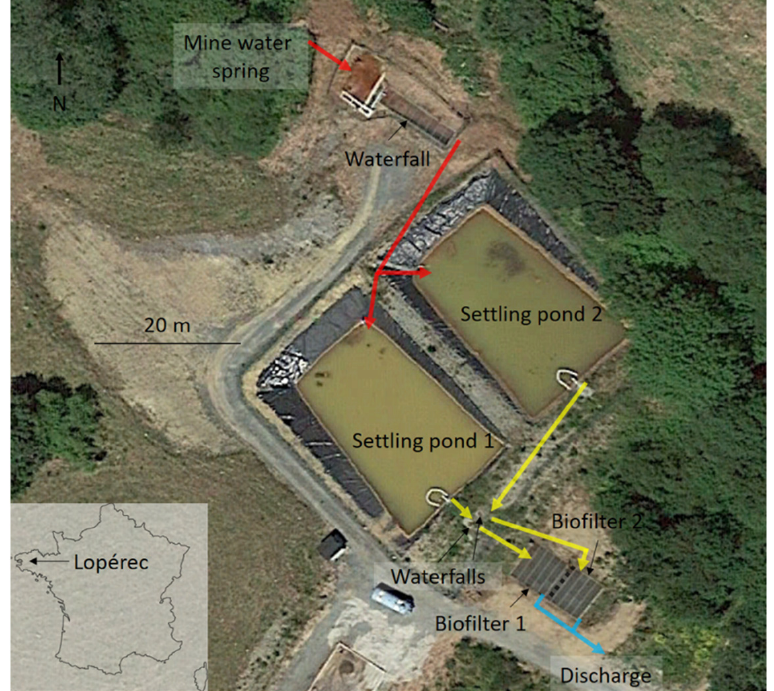
Figure 1. Lopérec mine drainage passive treatment system. Figure 1. Lop é rec mine drainage passive treatment